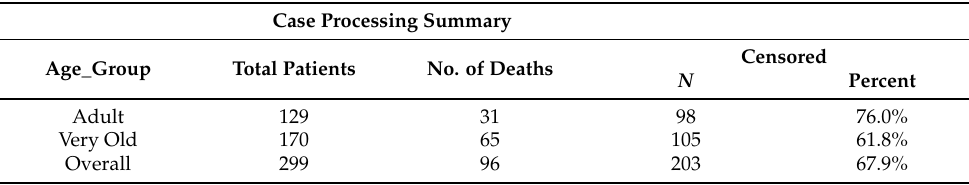
Table 11. Age group vs. Survival-Status Descriptive Summary.